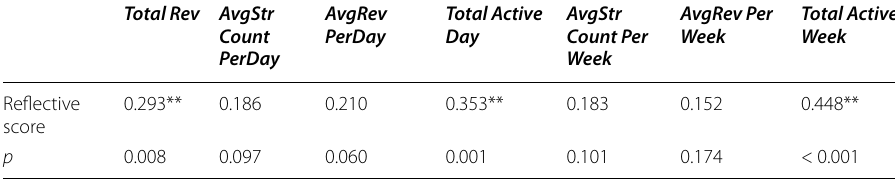
**Correlation is significant at the 0.01 level (2-tailed)